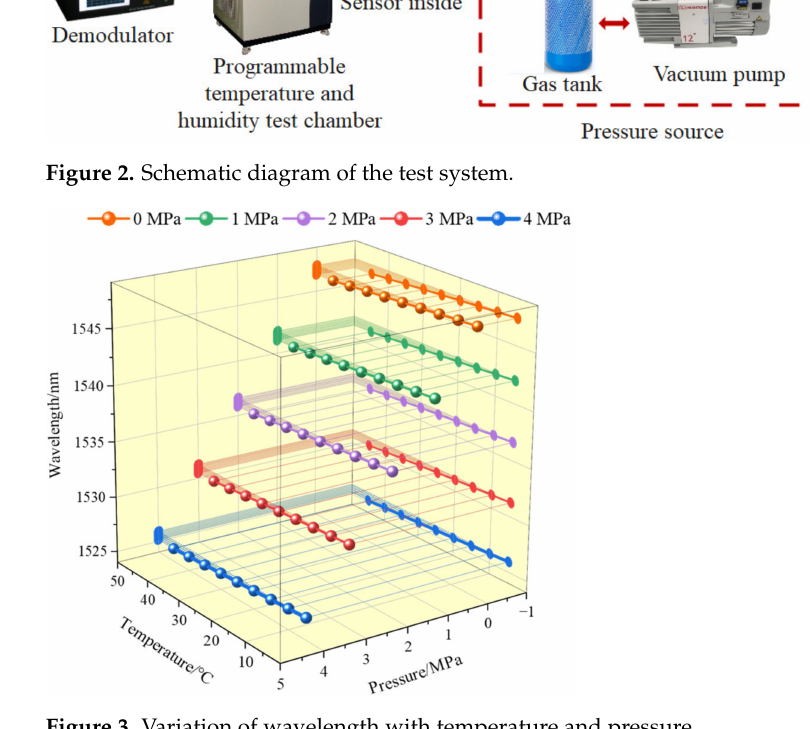
Figure 3. Variation of wavelength with temperature and